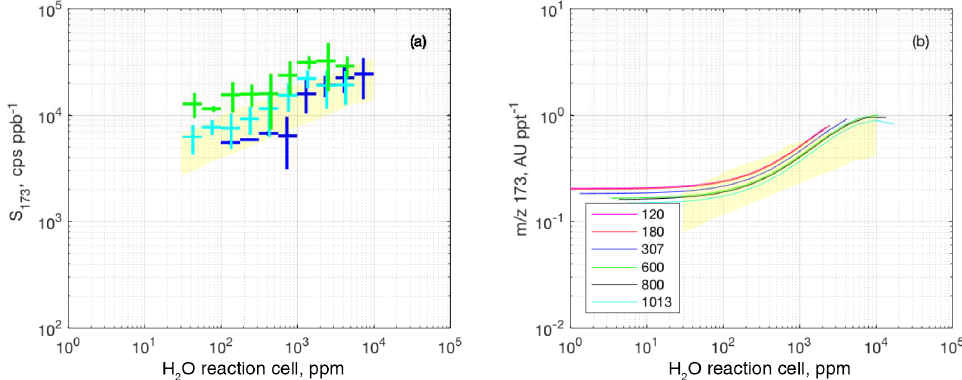
Figure 9. Same as Fig. 5 except for I − ( HFo ) . Field calibrations for HFo were not performed in DC3.